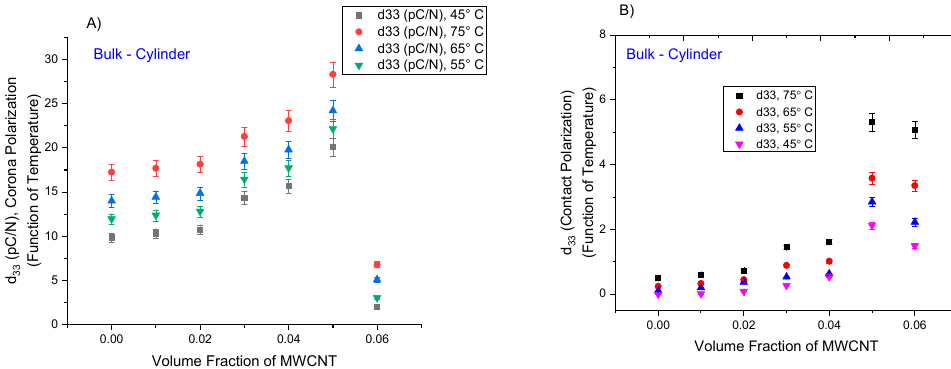
Figure 4. Variation in piezoelectric strain coefficient, d 33 for bulk disks as a function of temperature (45–75 °C) for ( A ) corona and ( B ) contact polarization techniques.